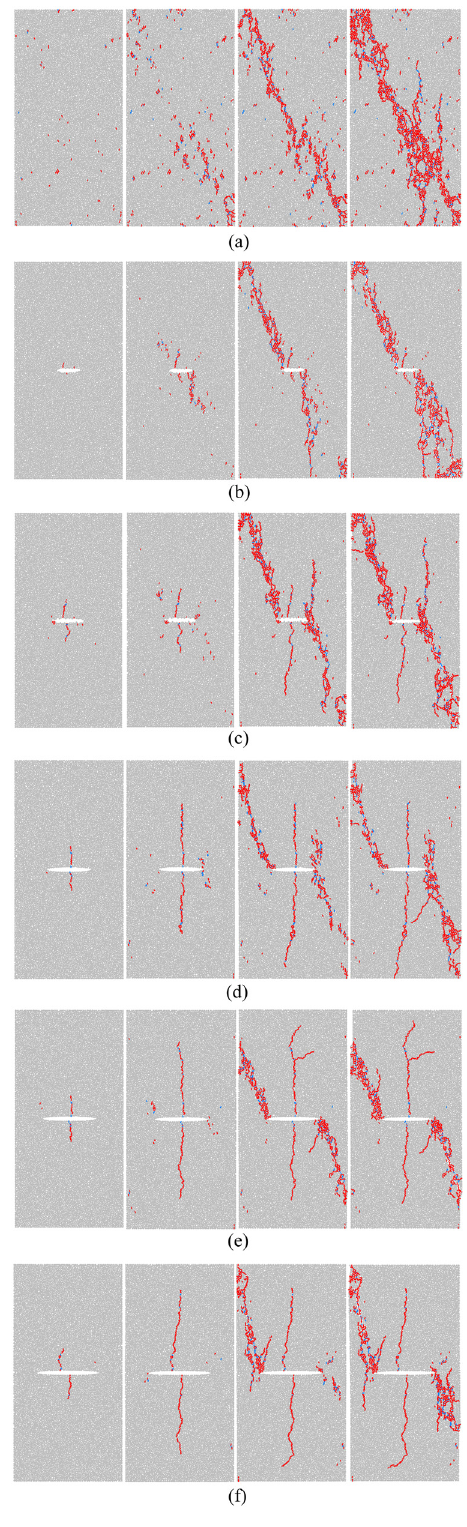
Figure 3: Micro - crack propagation of six numerical samples: ( a ) intact model, ( b ) a : b = 5, ( c ) a : b = 7.5, ( d ) a : b = 10, ( e ) a : b = 12.5, and ( f ) a : b =